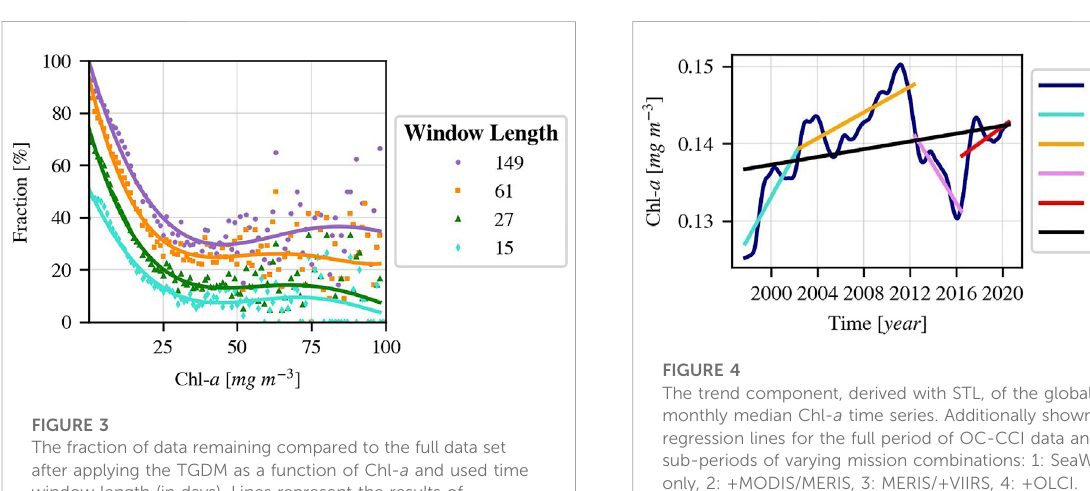
FIGURE 4 The trend component, derived with STL, of the global, monthly median Chl- a time series. Additionally shown are linear regression lines for the full period of OC-CCI data and the four